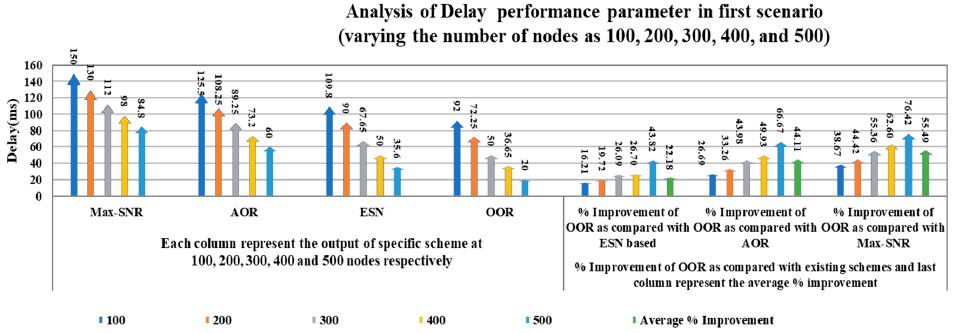
Figure 5. Detailed performance reflection of OOR with a delay parameter.